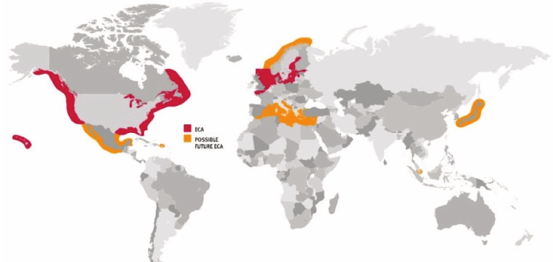
Fig. 1. Current areas ECA (red) and possible future zones (orange) [10]